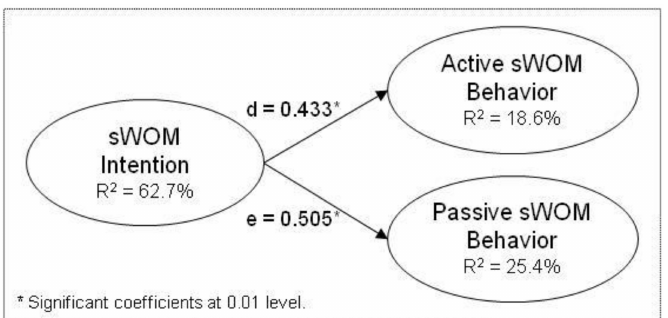
Figure 3. Structure of relationships for exploring the mediating effect: total effects on the model. Note: d = direct effect sWOM intention → active sWOM behavior; e = direct effect sWOM intention → passive sWOM behavior.